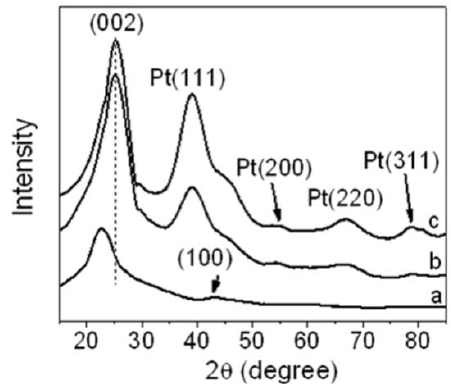
Figure 7. X-ray powder diffraction (XRD) patterns of ( a ) r-GO; ( b ) Pt NPs/r-GO and ( c ) Pt NPs/r-fGO hybrid